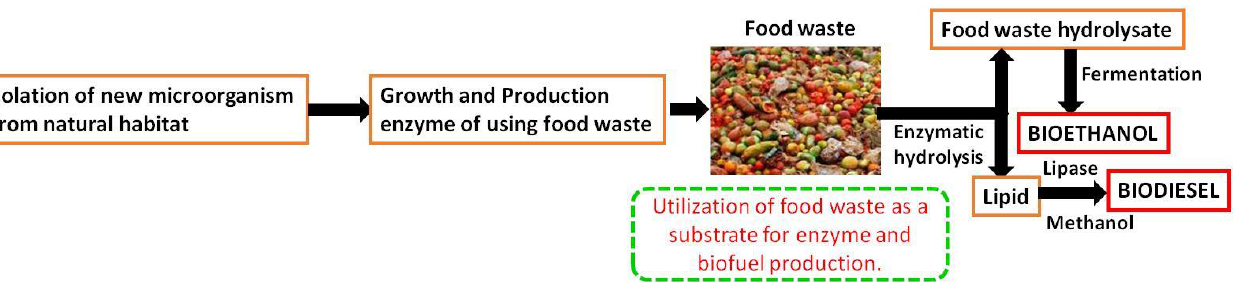
Figure 17. Plausible pathways for employing food waste as a substrate for enzyme and biofuel production.